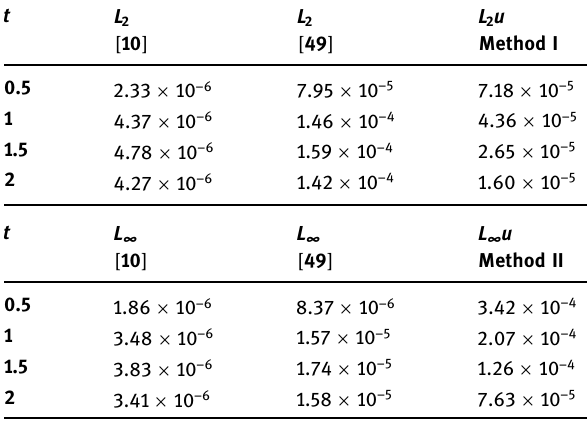
Table 4: Comparison of error at di ff erent time levels with = N 701 , = α 10 , = β 15 , = t Δ 0.0001 using Method I regarding Example